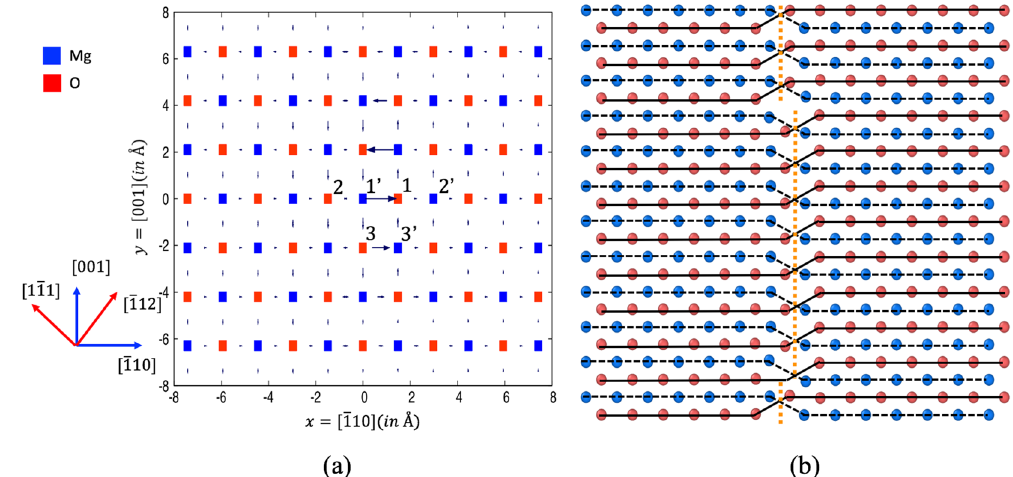
Figure 1. ( a ) The differential displacement map of the relaxed atomic coordinates through energy minimization for a screw dislocation in MgO. The x direction is [110] , the y direction is [001] and the screw dislocation line direction is [110]. Selected vacancy sites near the dislocation core are labeled: 1, 2, 3 for V O (1), V O (2), V O (3); 1’, 2’, and 3’ for V Mg (1), V Mg (2), and V Mg (3). (see text for details). The blue axes are for “configuration 1” and the red axes for “configuration 2” (see text). ( b ) A typical dislocation jog pair as observed in MD simulations of the MgO screw dislocation containing one O vacancy. The view is along the [001] direction. The horizontal direction is [110] and the vertical direction is [110]. The dislocation line position is marked with dashed orange lines. The layer of atoms plotted is the plane where the maximum differential displacement occurs. The blue spheres are Mg atoms and the red spheres are O